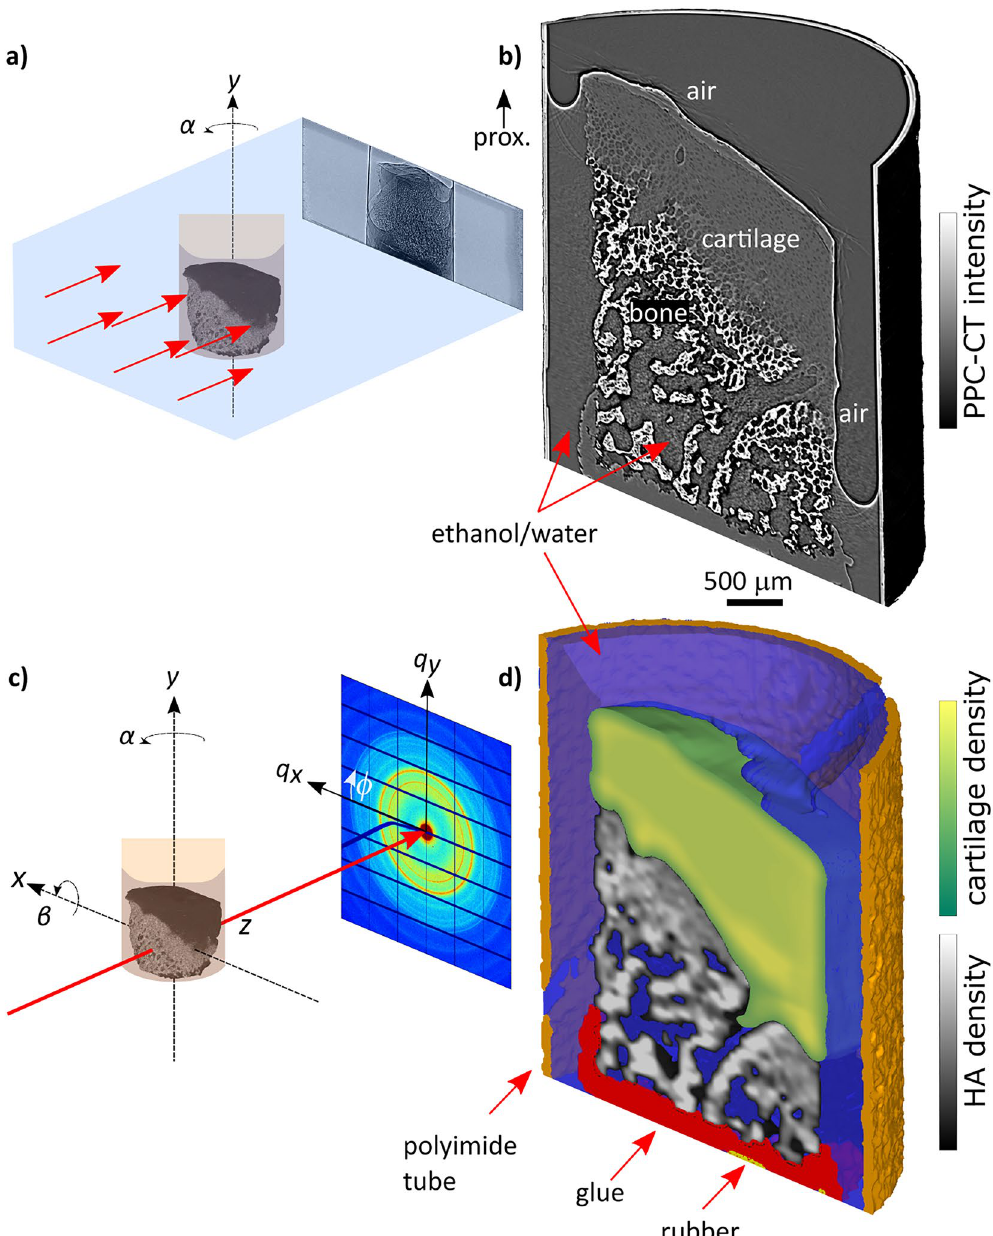
Figure 1. (a) Sketch of PPC-CT experimental setup. The sample is illuminated by a full-field X-ray beam, while rotated around y. Edge-enhanced propagation phase-contrast projections are recorded on the detector if the sample-detector distance is sufficiently long. (b) PPC-CT cutaway view of a bone/cartilage sample including the ethanol–water solution and polyimide sample container. Prox. proximal. (c) Sketch of a generic SASTT or XRDTT experimental setup. The sample is mounted onto a goniometer stage, allowing the sample to be raster- scanned in ( x , y ) and rotated around y (angle α ) and x (angle β ). A collimated X-ray beam penetrates the sample and 2D diffraction patterns are collected on the detector. (d) Material specific XRD-CT, cutaway